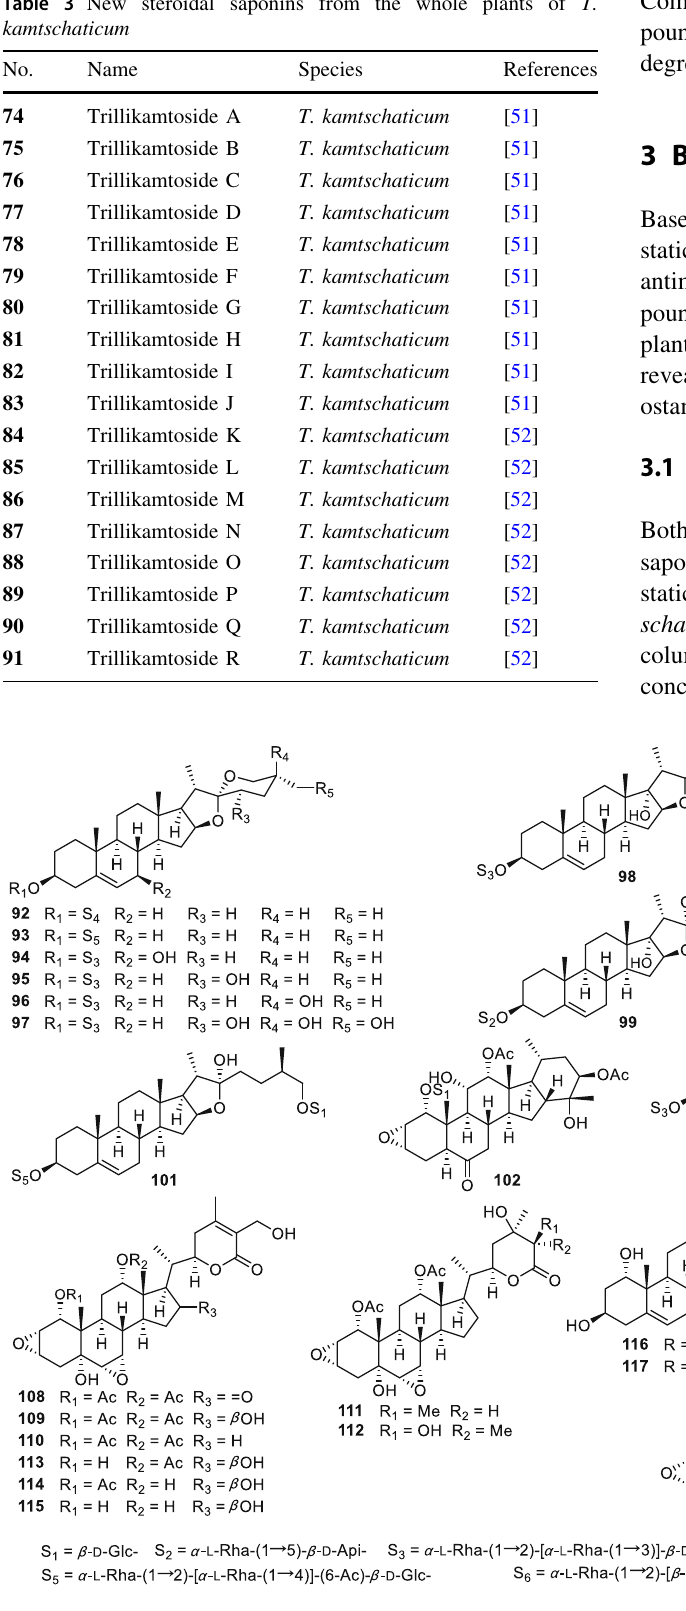
Fig. 4 New steroidal sapogenins and saponins from Tacca